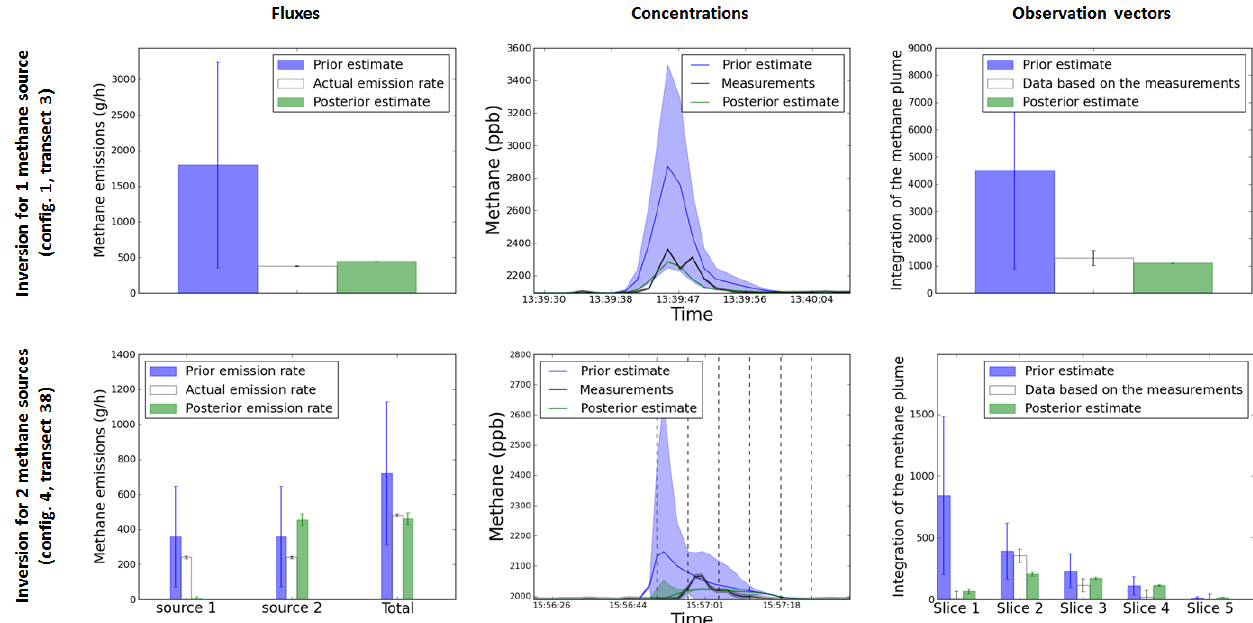
Figure 6. Examples of prior, posterior and measured values of emission rates, concentrations and values of the observation vector for cases in configuration 1 and 4 (observations from a single transect